Question: Which visualization type does this figure use?
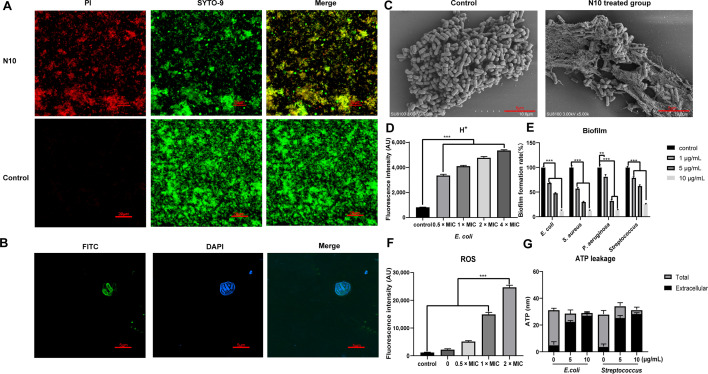
Answer: bar